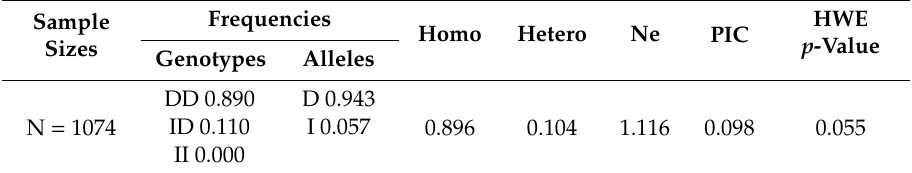
Table 1. Genetic parameters for the 5 bp indel of the SBWC goat MSTN (Myostatin) gene. Sample Sizes